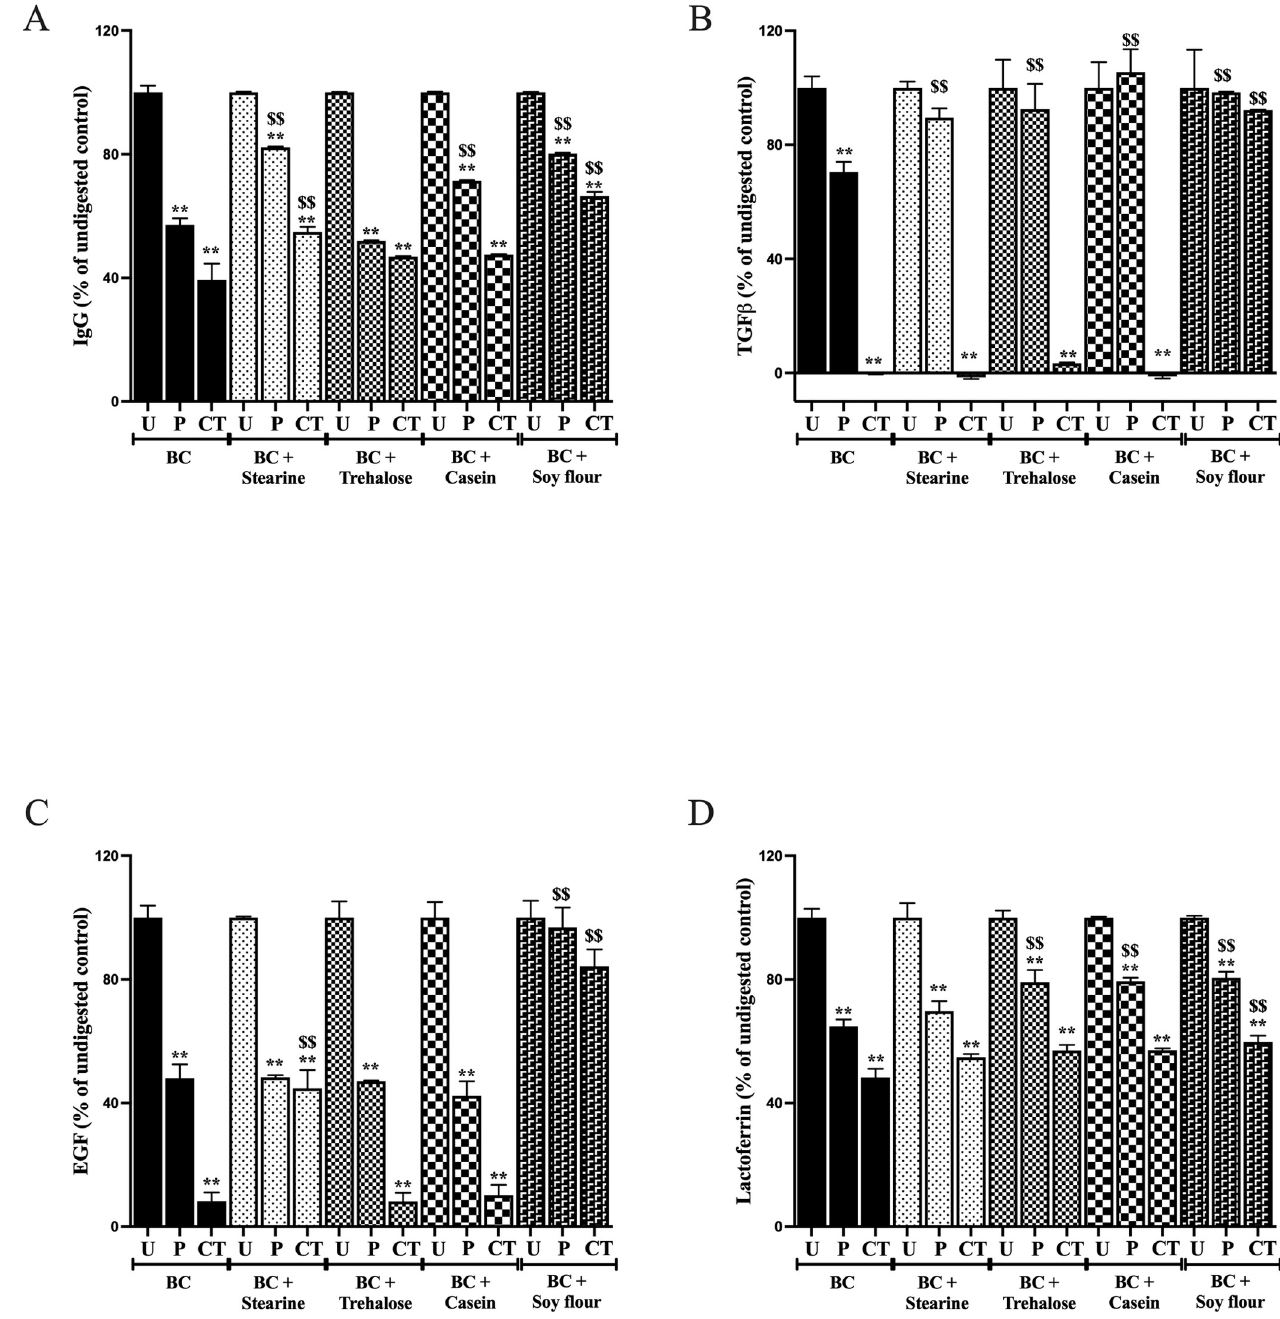
Fig 2. Influence of trehalose, stearine, casein and soy flour on growth factor and IgG immunoreactivity. BC alone, or in combination with test products, was subjected to digestion (see Fig 1A) and analysed by ELISA for effect on total bovine IgG (A), and the growth factors bovine TGF β (B), bovine EGF (C) and bovine lactoferrin (D). Aliquots of undigested samples (U) were compared against results following HCl/pepsin (P) and chymotrypsin + trypsin (CT) digestion. Results expressed as mean +/- SEM for 4 wells. �� signifies P < 0.01 vs undigested sample, $$ signifies P < 0.01 vs equivalent digested BC control.